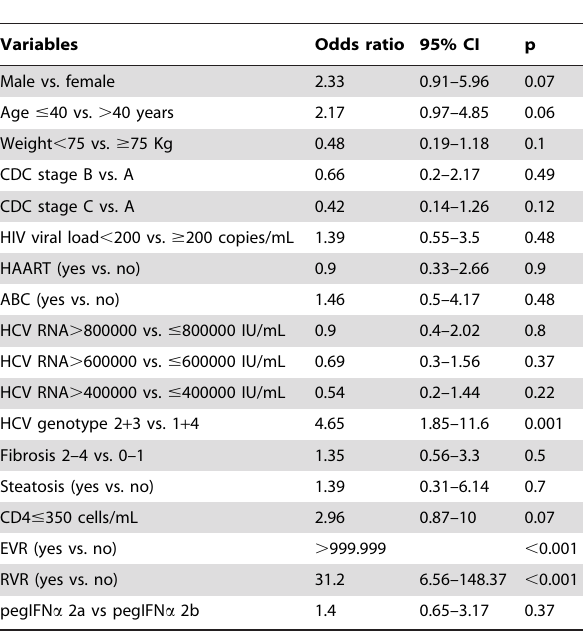
Table 4. Association of clinical, biochemical, and therapeutic factors with SVR in patients who completed the scheduled 48- week treatment regimen with pegIFN a and ribavirin.